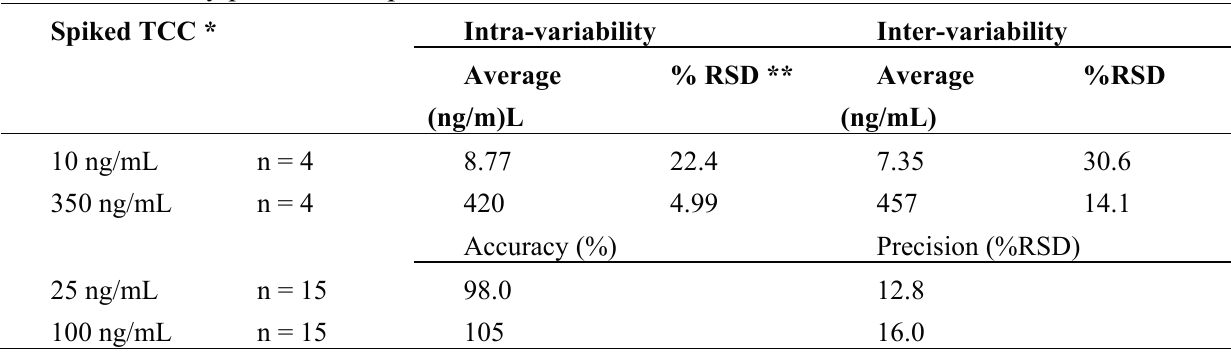
Table 1. Assay performance parameters. Spiked TCC * Intra-variability